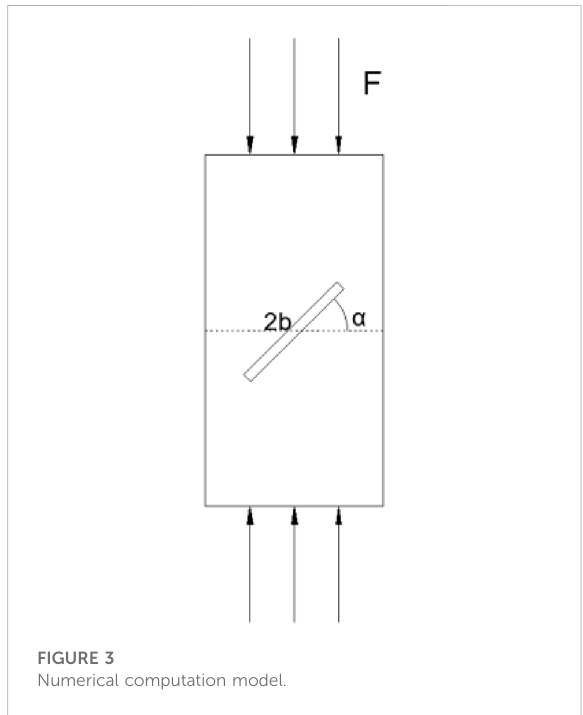
FIGURE 3 Numerical computation model.